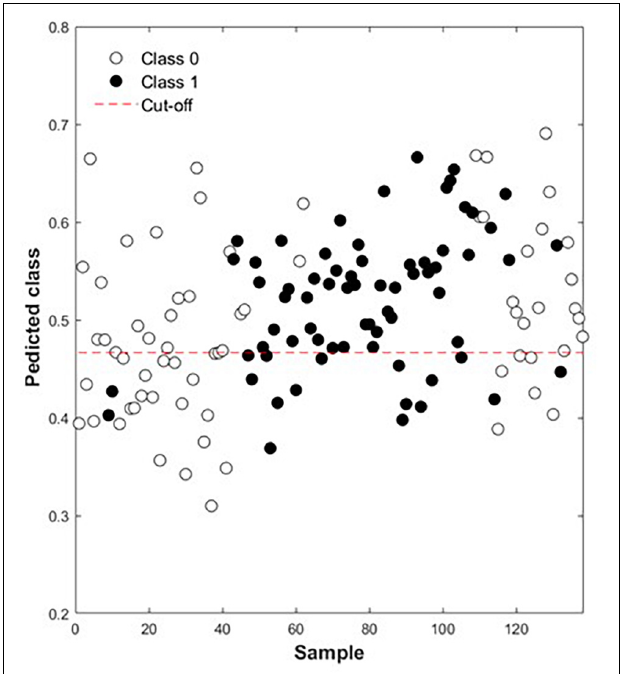
FIGURE 3 | Absence (Class 0, open circle) or presence (Class 1, close circle) of friction browning in ‘Regal Seedless’ table grape bunches performed by PLS-DA model, based on NIR spectral data for Weeks 3 and